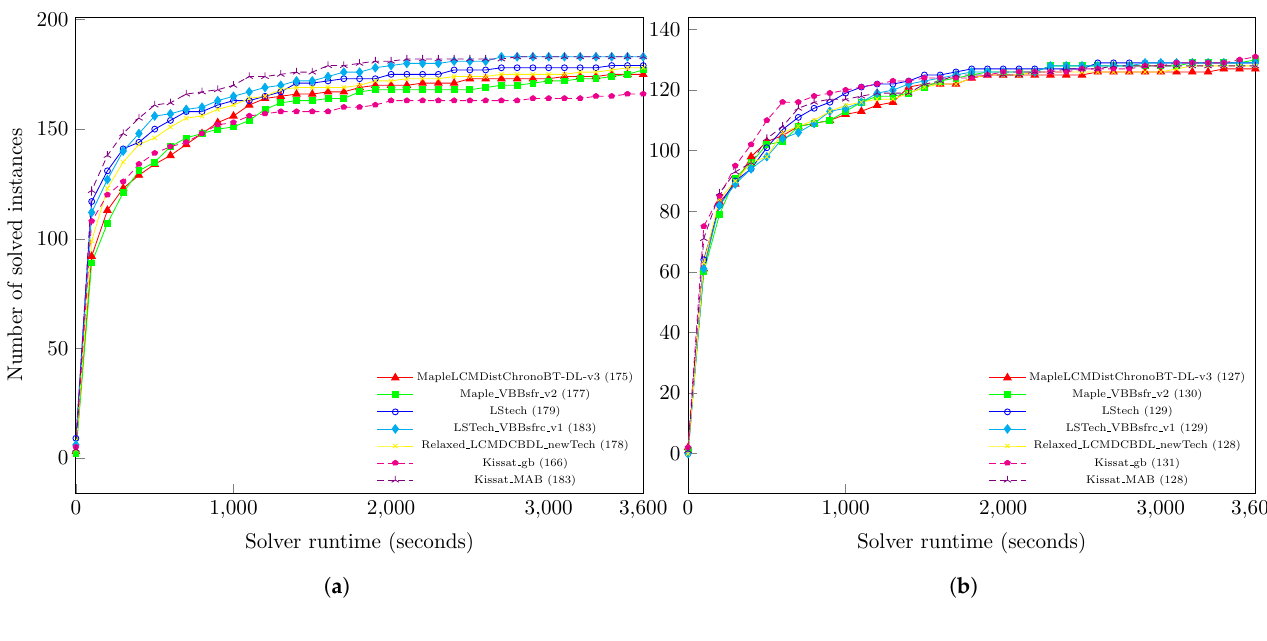
Figure 4. Performance results of Maple_VBBsfr_v2 and LSTech_VBBsfrc_v1 with state-of-the-art CDCL SAT solvers. Subfigures ( a , b ) illustrate results on satisfiable and unsatisfiable industrial benchmarks,